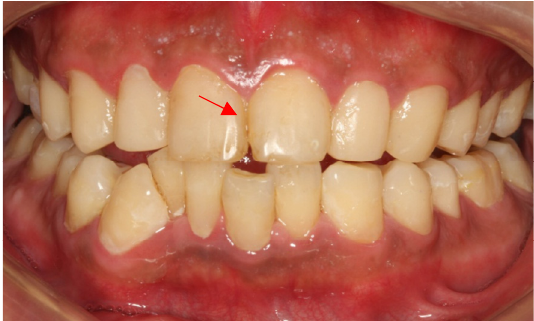
Figure 7. Two years after treatment.